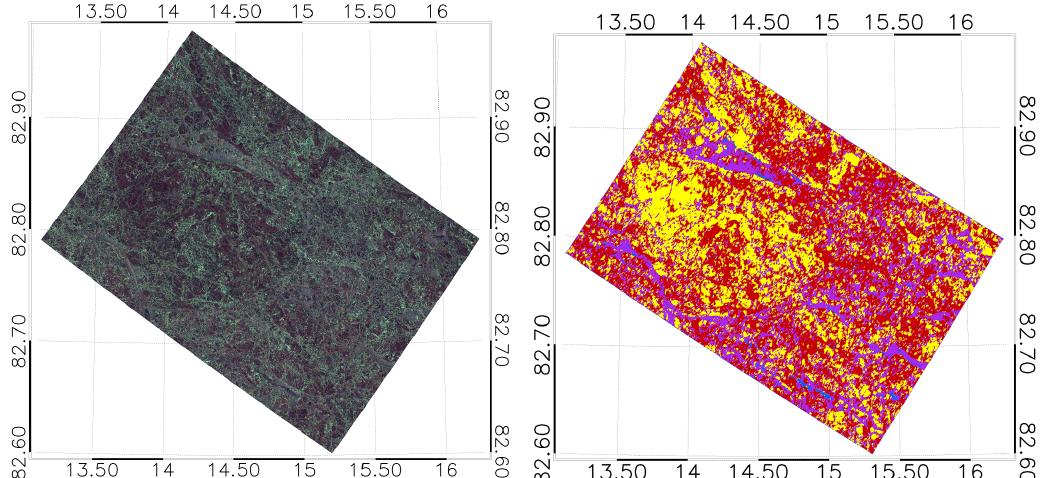
Figure A5. ( Left ) Geocoded Pauli RGB composite (Red: HH-VV Green: HV+VH Blue: HH+VV) of the RS-2 acquisition on 19 April 2015, frame 3; ( Right ) ice classification. Blue: open water/nilas (OW), purple: young ice (YI), yellow: first year ice (SFYI), red: rough first year ice/multi-year ice